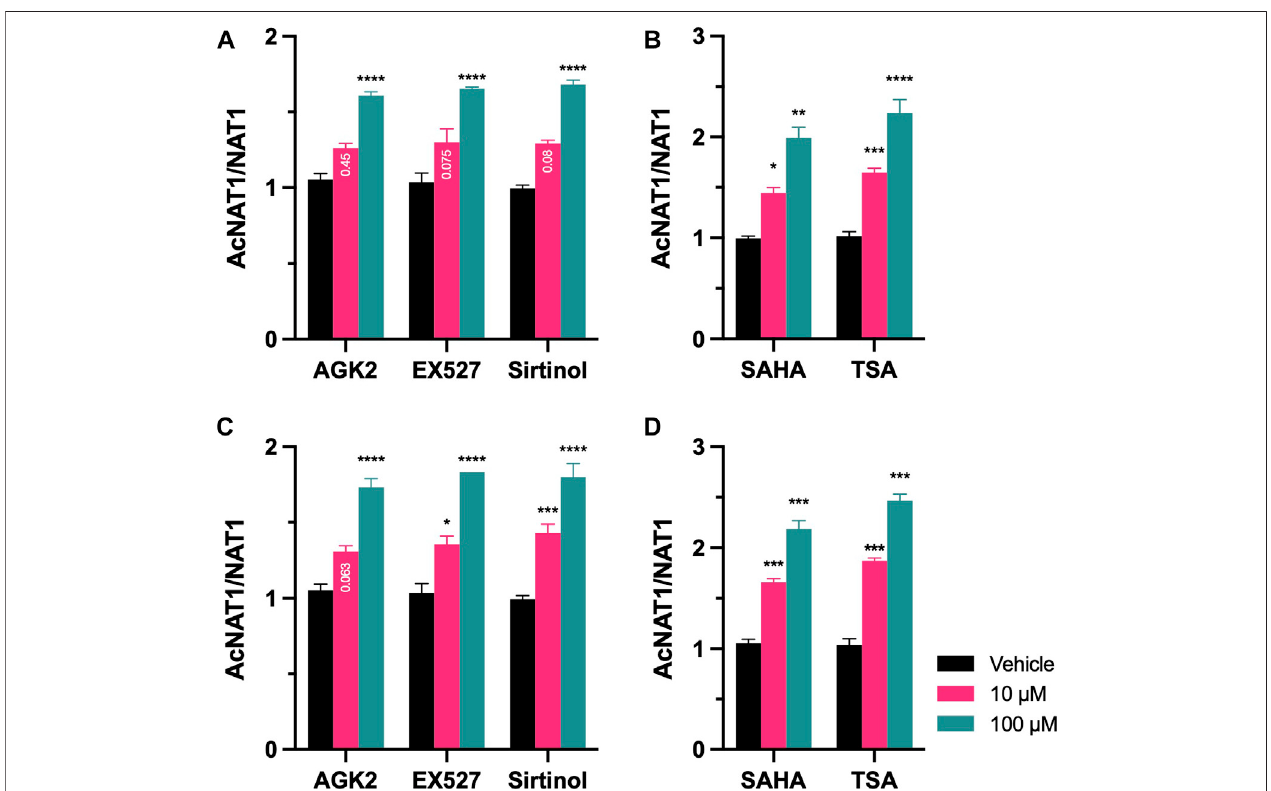
FIGURE 6 | Acetylation status of NAT1 after treatment with KDAC inhibitors. (A) MDA-MB-231 or (C) ZR-75-1 cells were treated with AGK2, EX527 or Sirtinol for 48-h,thenac-LysinewasimmunoprecipitatedandprobedforNAT1proteinexpression. (B) MDA-MB-231or (D) ZR-75-1cellsweretreatedwithSAHAorTSAfor48-h, then ac-Lysine was immunoprecipitated and probed for NAT1 protein expression. Data represents the ratio of AcNAT1/NAT1 abundance. Data is presented as the mean ± SEM of three independent experiments. *, p < 0.05; **, p < 0.01; ***, p < 0.001; ****, p < 0.0001 compared vs. vehicle